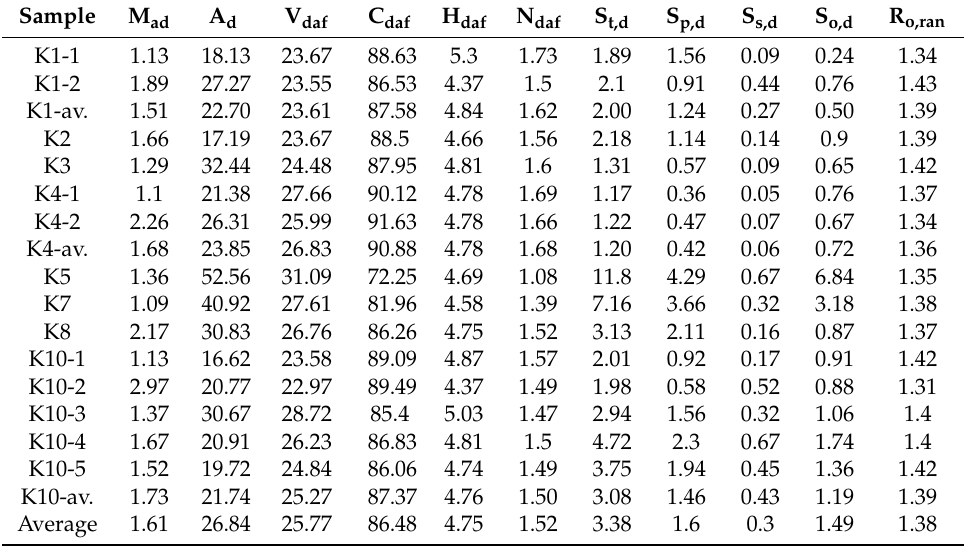
Table 1. Proximate and ultimate analysis, forms of sulfur, and random vitrinite reflectance for coals from the ZK4-1 drill core in the Zhongliangshan Coalfield (%).